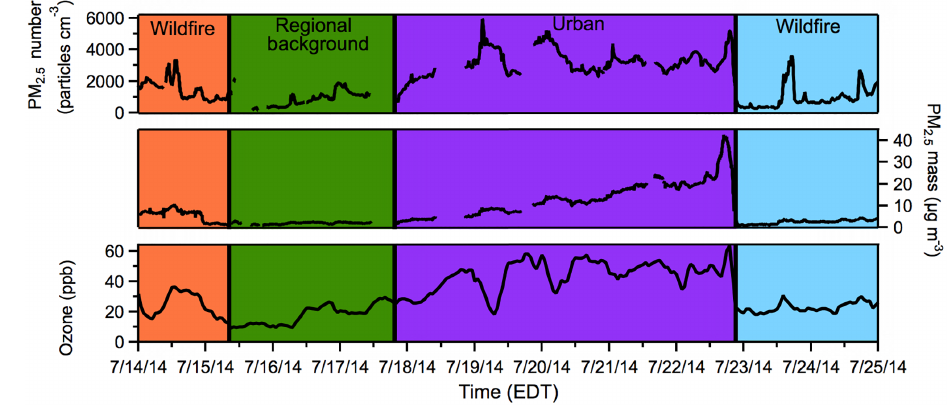
Figure 1. Time-resolved PM 2 . 5 number and mass concentrations and ozone mole ratios during the different periods of air mass influence. Periods without data are due to instrument downtime. Colors of the different time periods correspond to the colors of the corresponding HYSPLIT backward air mass trajectories in Fig. S2.